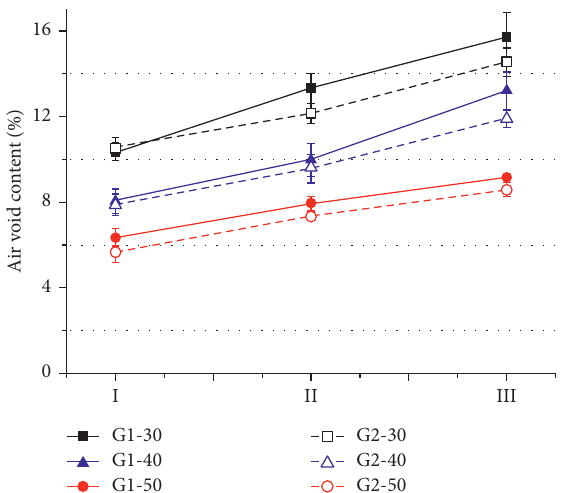
Figure 8: Air void distribution under different gyratory compaction